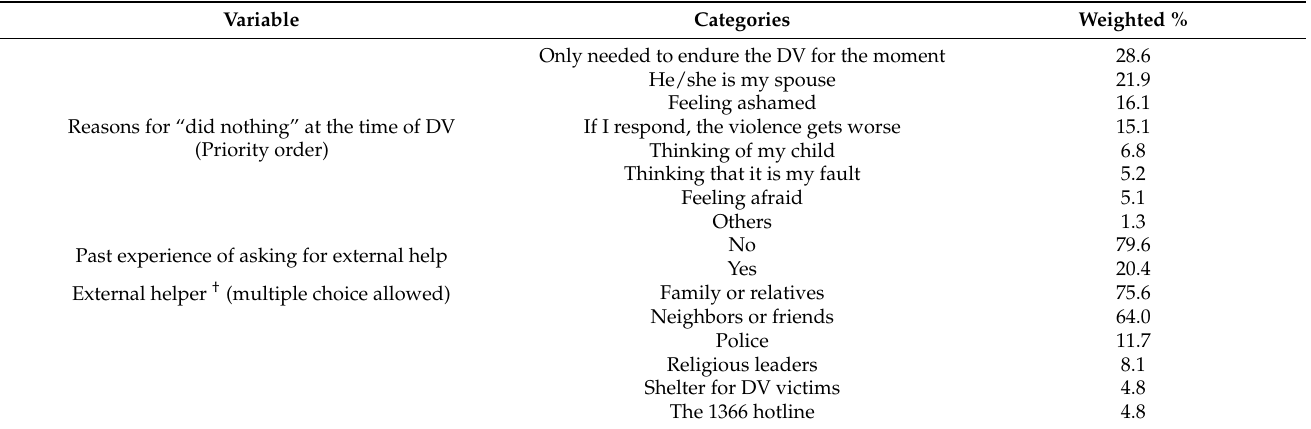
Table 2. Reasons for “did nothing” at the time of DV and past experience of asking for external help ( n = 309).